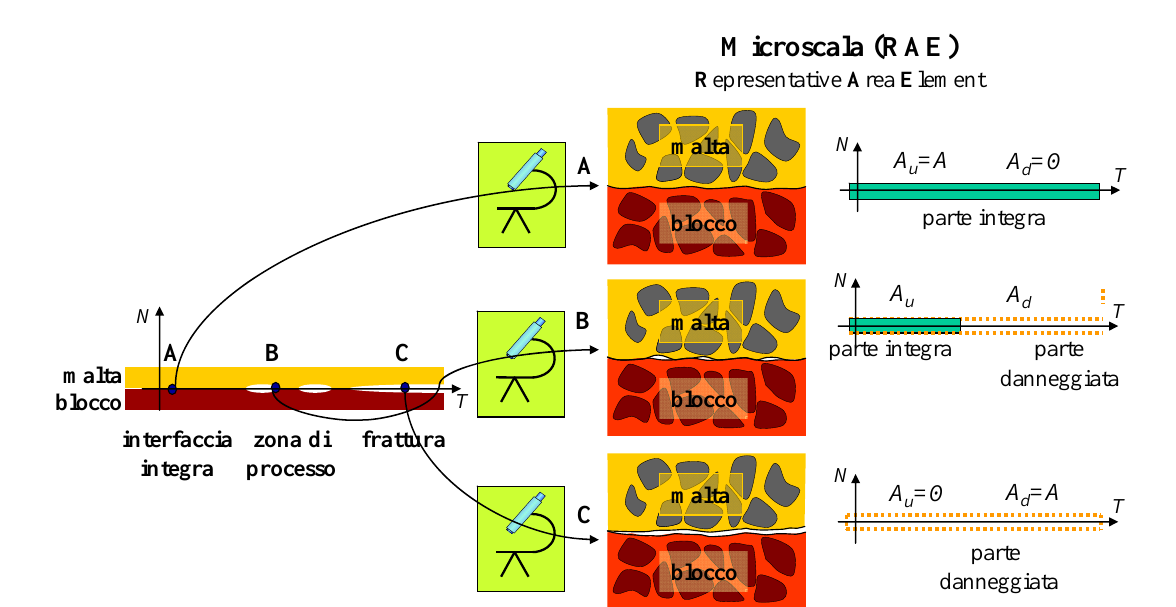
Figura 1: Modello micromeccanico dell’interfaccia